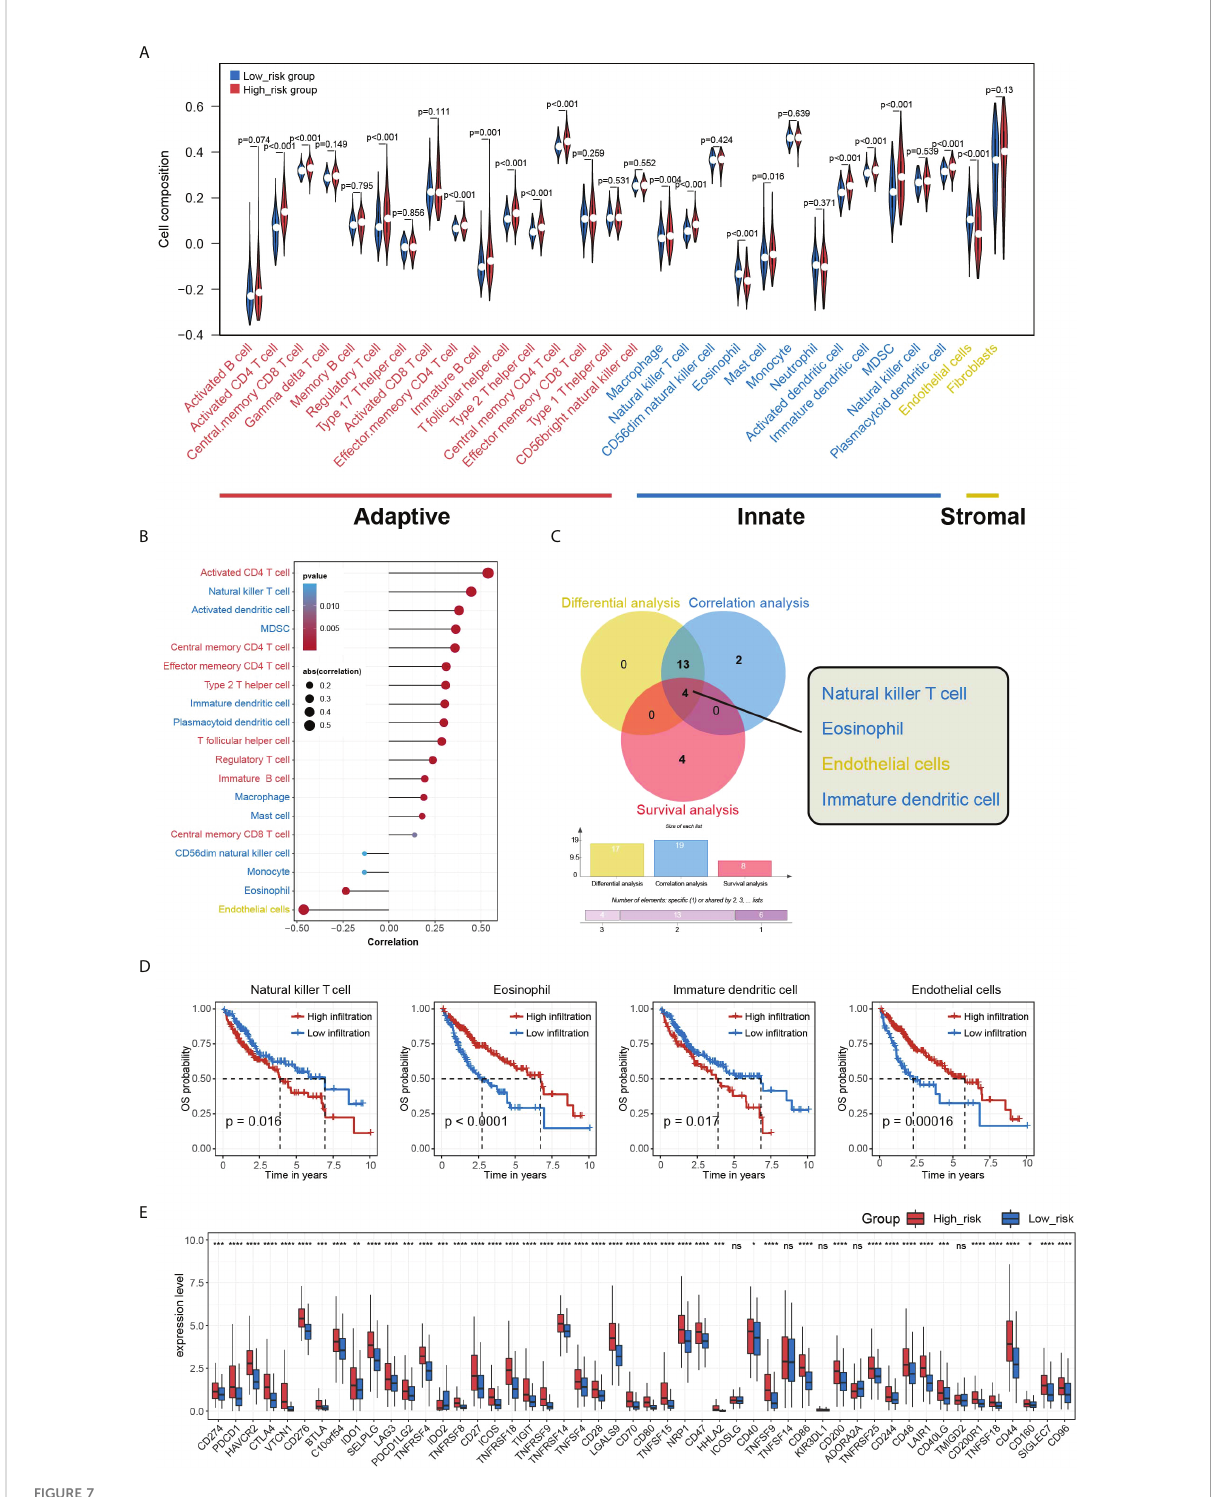
FIGURE 7 Overview of HGSIS-related immune in fi ltration. (A) Violin plot presenting the relative composition of multiple cell types in the low- and high-risk groups. (B) Correlation analysis of immune in fi ltration and HGSIS risk score. (C) Venn diagram revealing the four intersected cell types among differential analysis (yellow), correlation analysis (blue), and survival analysis (red). (D) Kaplan – Meier survival analysis of the four TME cell types. (E) Expression levels of common immune checkpoints in two HGSIS risk groups. TME, tumor microenvironment. * means p < 0.05; ** means p < 0.01; *** means p < 0.001; **** means p < 0.0001; ns, no signi fi